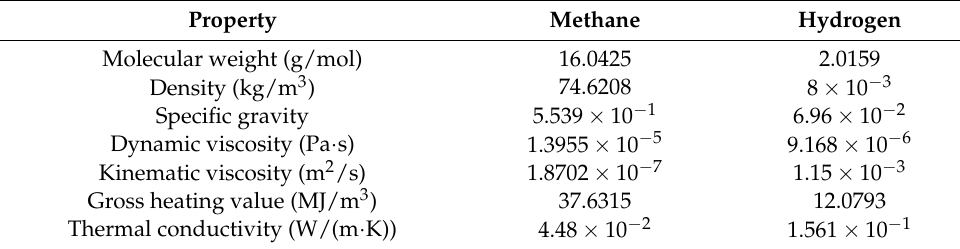
Table 1. Properties of natural gas and hydrogen at 100 bar and 303